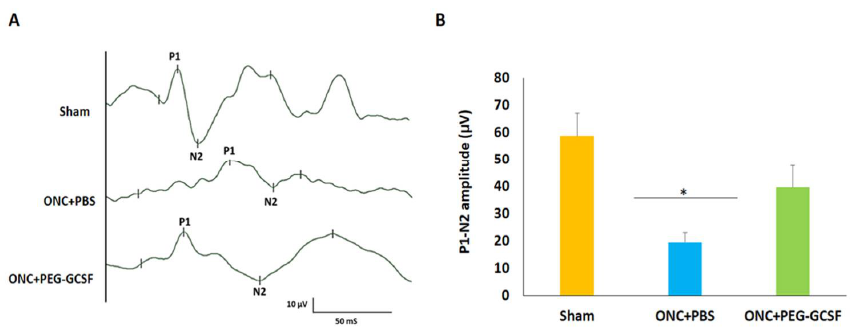
Figure 4. Assessment of visual function by flash visual-evoked potential (fVEP) examination 14 days after optic nerve crush (ONC). ( A ) Representative records of fVEP wavelets in the sham group, the phosphate-buffered saline (PBS)-treated and the pegylated granulocyte colony-stimulating factor (PEG-G-CSF)-treated ONC groups. ( B ) The bar chart showed the measure of the peak to peak amplitudes of P1–N2. There was a significant improvement in the fVEP in the PEG-G-CSF-treated group as compared with that in the PBS-treated group after ONC (* p < 0.05, n = 6). P1, the first positive peak; N2, the second negative peak. Data are expressed as mean ± standard deviation (SD).